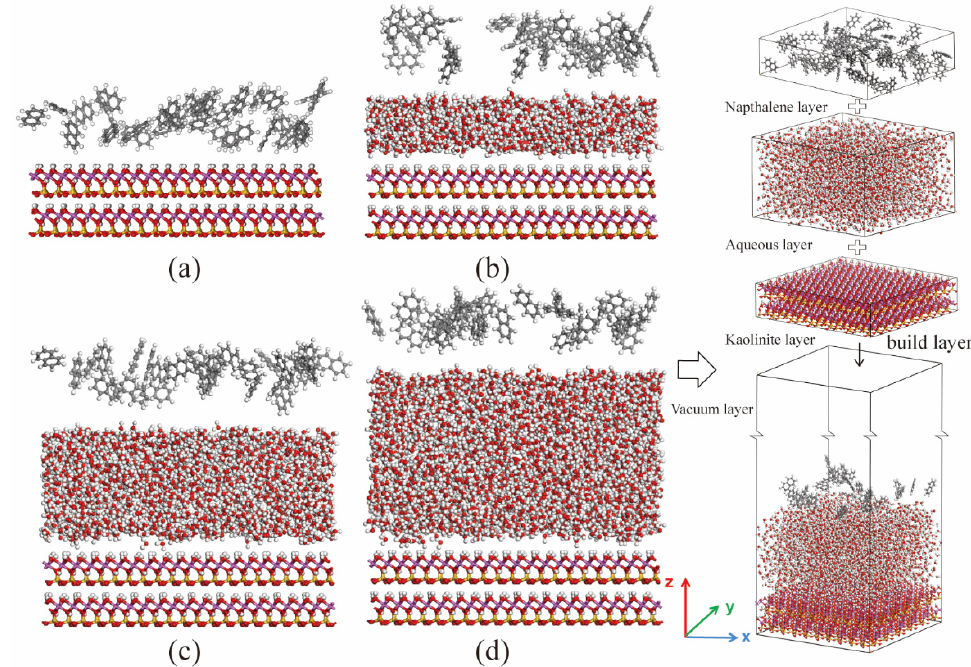
Figure 2. The initial configuration of the ternary model with different thicknesses of the water film.